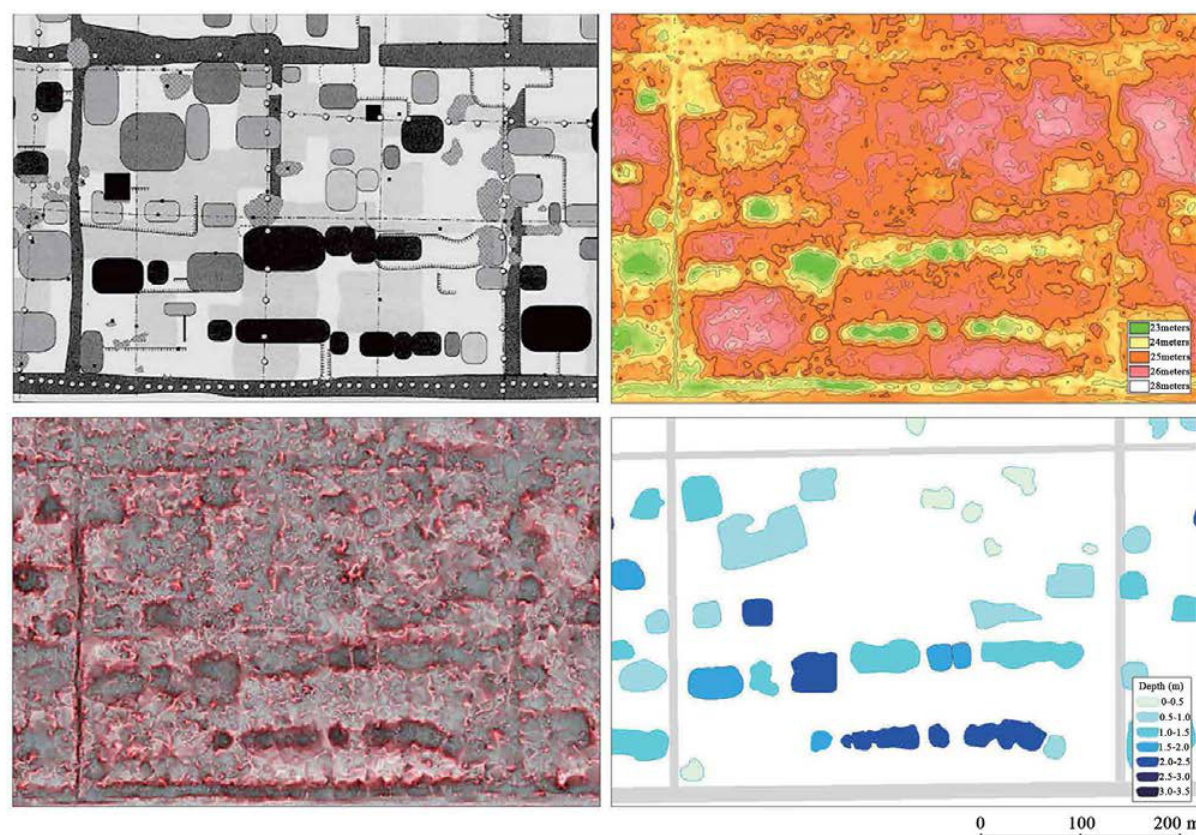
Figure 4. Distribution of ponds in a specific area of Angkor Thom surrounded by water channels(Shimoda et al.,2016;Fig7). The location of this area is shown in Figure 3. In this area, it is particularly difficult to distinguish the shape of each pond, as it is thought that ponds were dug overlapping each other, and also due to erosion and sedimentation. (Above left: map of field survey by Gaucher, 2004, Figure 17; above right: Shaded relief and contour lines (1 m) based on LiDAR data; below left: High- resolution RRIM; below right: Reconstruction of ponds from High-resolution